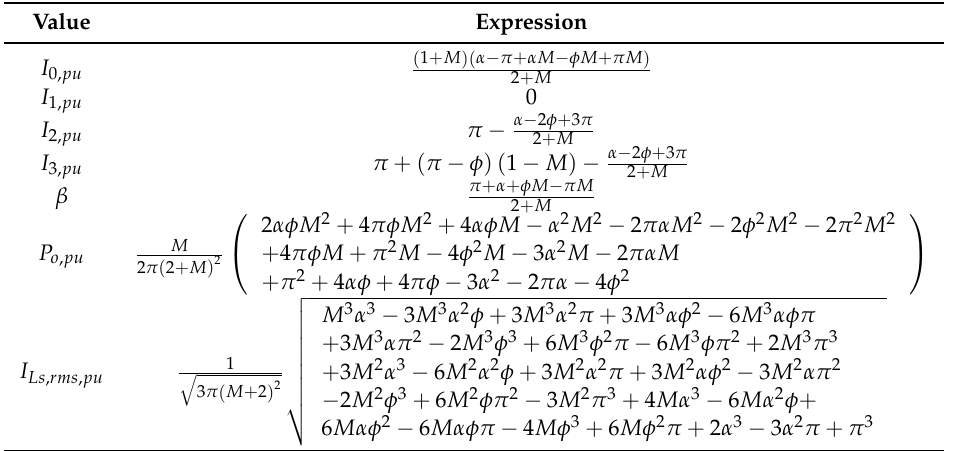
Table 1. Theoretical values of inductor current and output power in Mode A.